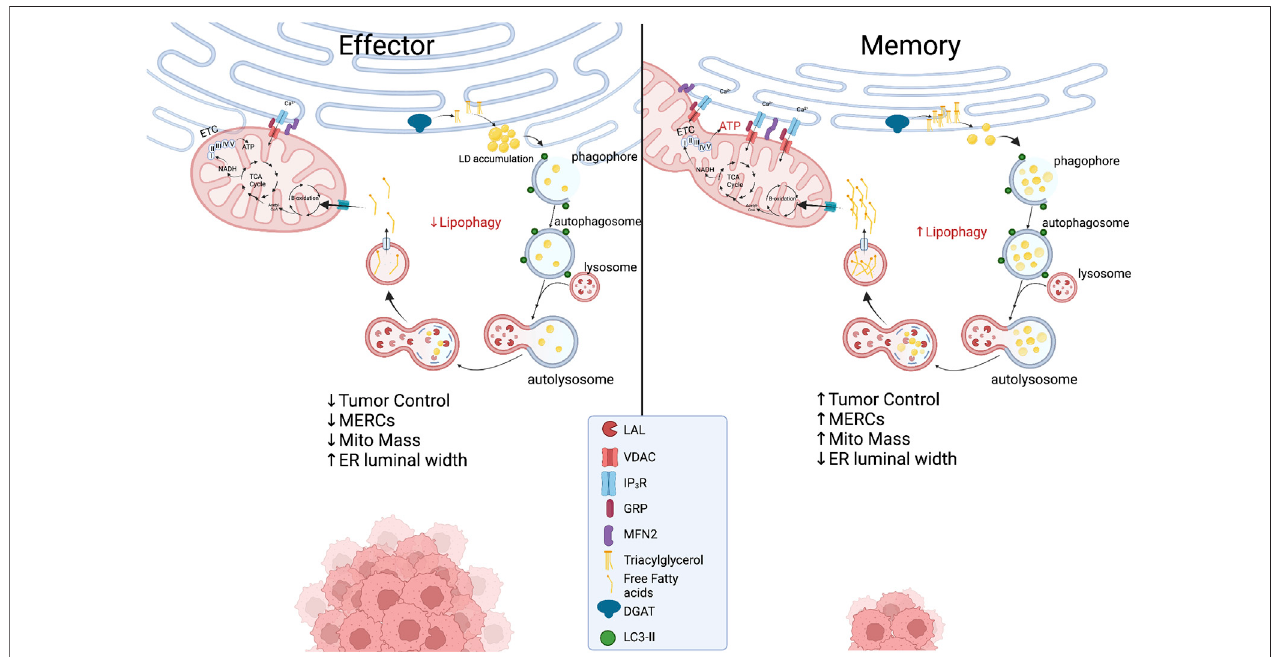
FIGURE3| ProposedmetabolicmodelattheER-mitochondriainterfaceinwhicheffectorTcellswithexpandedERmorphologyexperiencechronicERstresswhile displayinglimitedMERCswithpunctateandfragmentedmitochondria.InmemoryTcells,ERenzymeDGAT1synthesizestriacylglycerides(TAGs)storedinlipiddroplets that are concurrently degraded through lipophagy by LAL. The process could be accelerated in the nutrient stress of the tumor microenvironment, providing liberated free fatty acids to fused mitochondria to support energy generation in TILs. Created with BioRender.com.